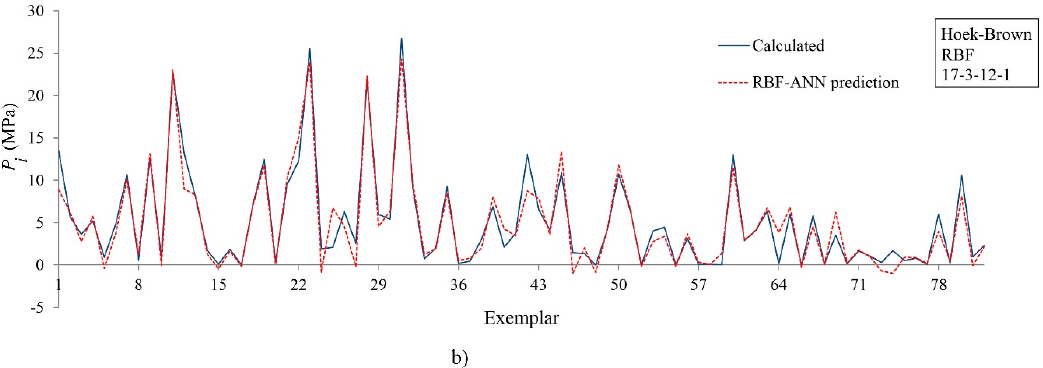
Figure 7. ( a ) Neural predicted P i versus calculated P i ; ( b ) differences between neural predicted P i and calculated P i for the best RBF-ANN (17-3-12-1) applied to the testing data series for the Hoek–Brown criterion.